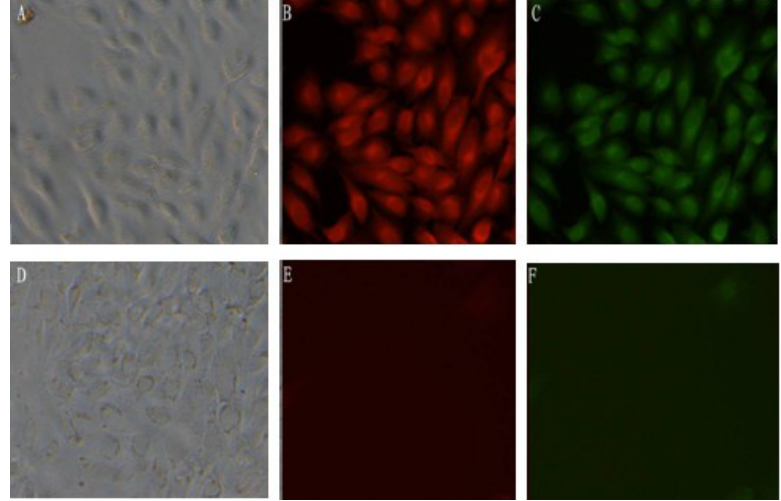
Figure 2. Expression of the mBD1-mBD3 fusion protein in MDCK cells (×200). Stable expression of the mBD1-mBD3 fusion protein in MDCK cells transfected with pcDNA3.1(+)/ mBD1-mBD3 or pcDNA3.1(+) was analyzed by indirect Immunofluorescence. Expressions of mBD1 and mBD3 protein emitting red and green fluorescence respectively were observed in MDCK-pcDNA 3.1(+)/ mBD1-mBD3 ( A – C ) . No fluorescence could be observed in MDCK-pcDNA 3.1(+) ( D – F